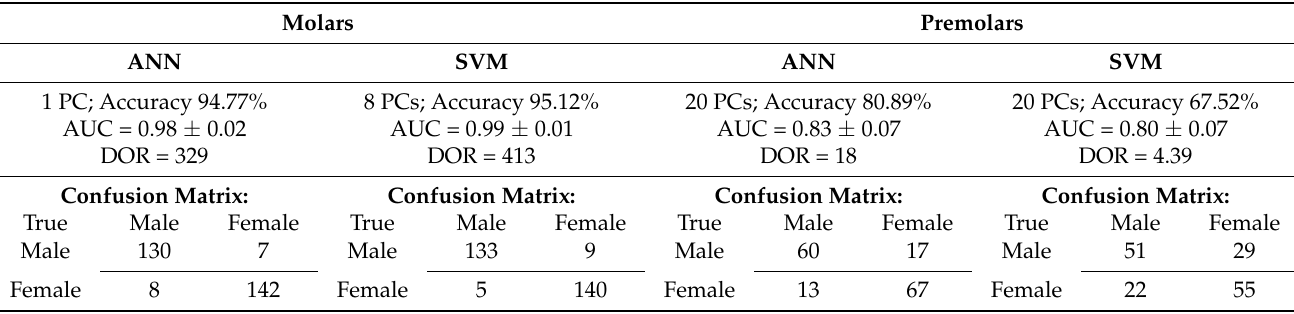
Figure 4. Cross-validation classification accuracy obtained by ANN and SVM in dependence on the number of used PCs for all calculated models: Molar apex and molar anatomical neck; premolar apex and premolar anatomical neck. Lines between symbols were added as a visual aid. Table 2. Cross-validation confusion matrices for models with highest obtained success rate (apex models). AUC values with their respective 95% confidence intervals and calculated DOR values are also